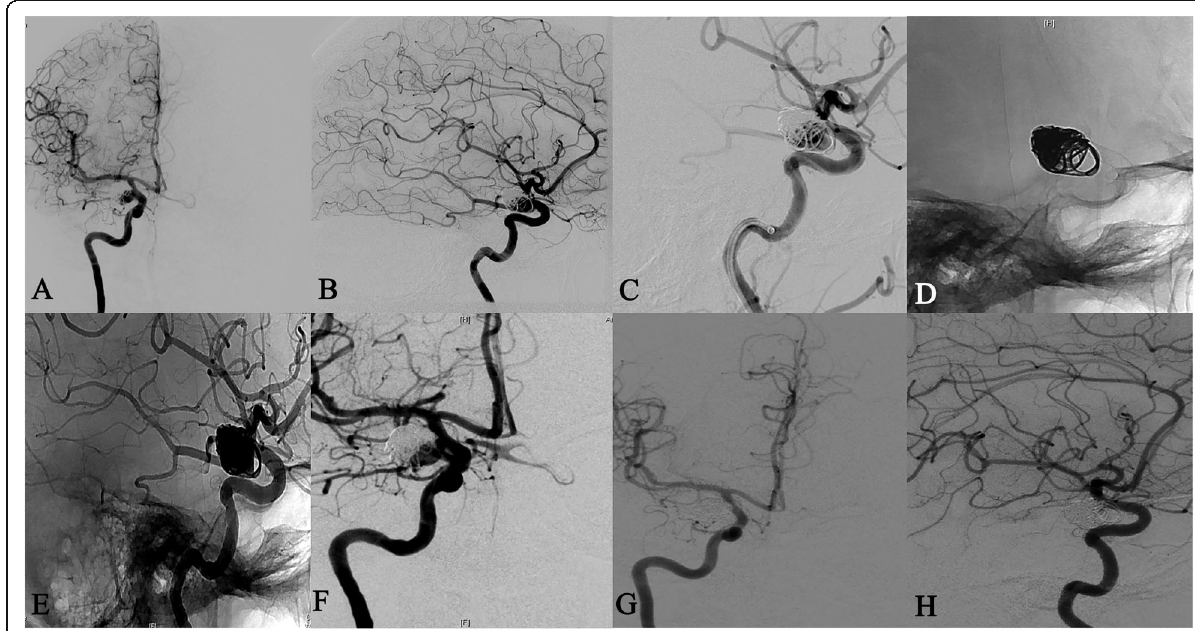
Fig. 3 a – c DSA of 43-years old patient, showing recanalized right PCOM aneurysm 1 year after coiling. d Insertion of single PED stent 4 × 16 mm. e , f Angiography immediately after PED deployment. g , h One-year follow-up revealed complete occlusion of the